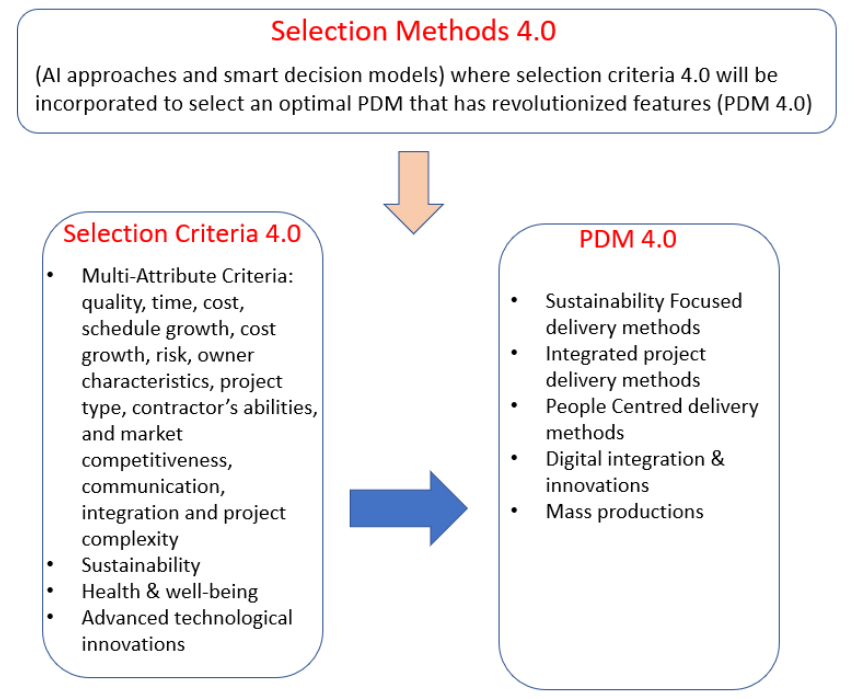
Figure 8. Framework of the relationship between PDM variables.